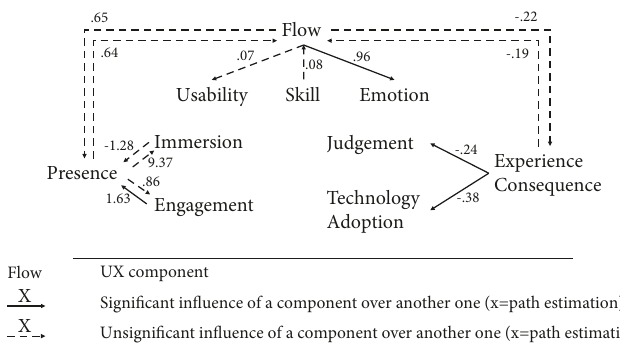
Figure 3: Standardized path estimation coefficient of the structural model of the hypothesized UXIVE Model.